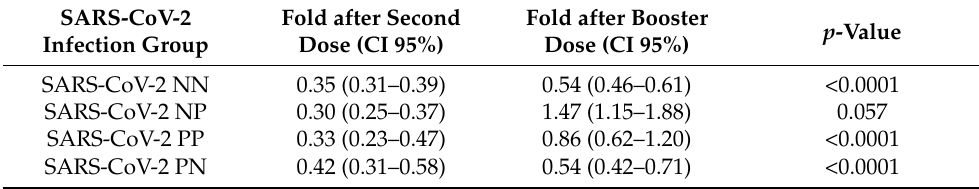
Table 3. Fold changes after dose 2 and after booster dose and intragroup comparison.